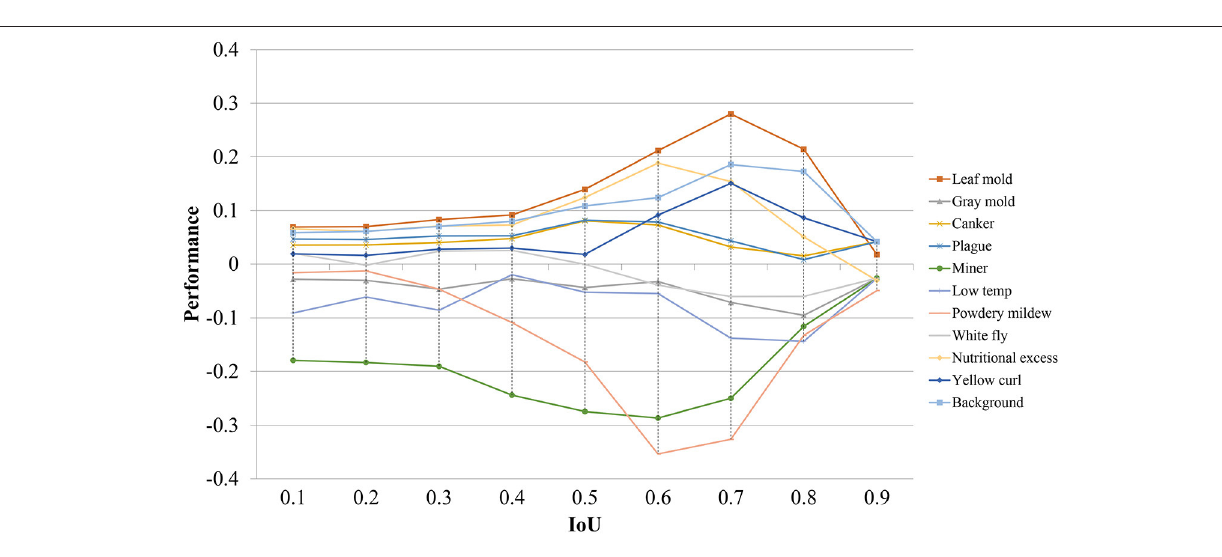
and aims to TP + FN using the filter bank. (The TP + FP